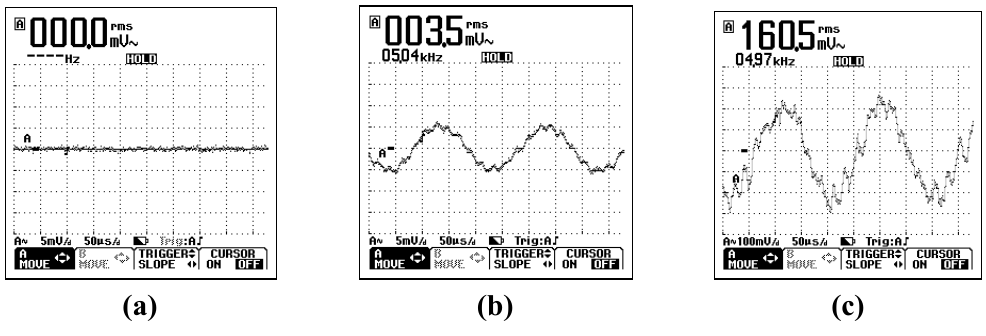
Figure 13. Communication along the pipe (a) without amplification, (b) with amplification and (c) with pre-amplification [29].